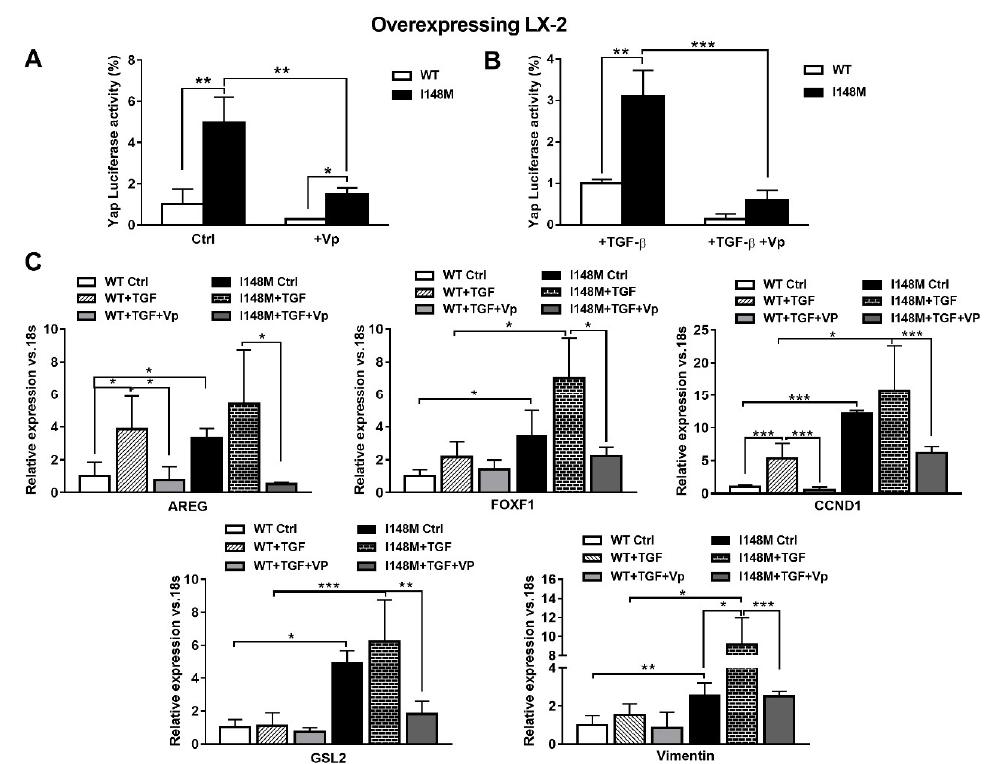
Figure 4. Verteporfin inhibits TGF- β mediated Hedgehog / Yap target gene expression. LX-2 stably overexpressing cells ( n = 3 each PNPLA3 genotype) was obtained and cultivated in vitro, as described in Materials and Methods. Where indicated, cells were stimulated with Vp and TGF- β , respectively, for 24 and 1 h prior to the analysis. ( A ) Luciferase activity (%) in HSCs transiently transfected with Yap-promoter luciferase construct untreated (Ctrl) or treated with Vp. * = p < 0.05, ** = p < 0.01 as indicated in the graph. ( B ) Luciferase activity in HSCs transiently transfected with Yap luciferase construct and treated with only TGF- β or with combination of TGF- β + Vp. ** = p < 0.01, *** = p < 0.001 as indicated in the graph. ( C ) Expression of AREG, FOXF1, CCND1, GLS-2 and Vimentin was analyzed by real-time PCR and normalized to 18s. * = p < 0.05, ** = p < 0.01, *** = p < 0.001 between groups as indicated in the graph. Data displayed represent three independent experiments performed in duplicates. Data shown as mean values ±